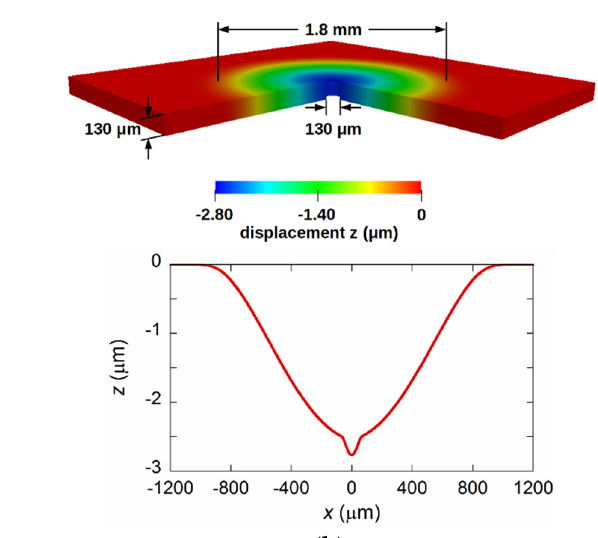
Figure 12. Normalized photocurrent signal induced by light wave interference for a sensor with a diamond membrane diameter of (190 ± 10) µ m.